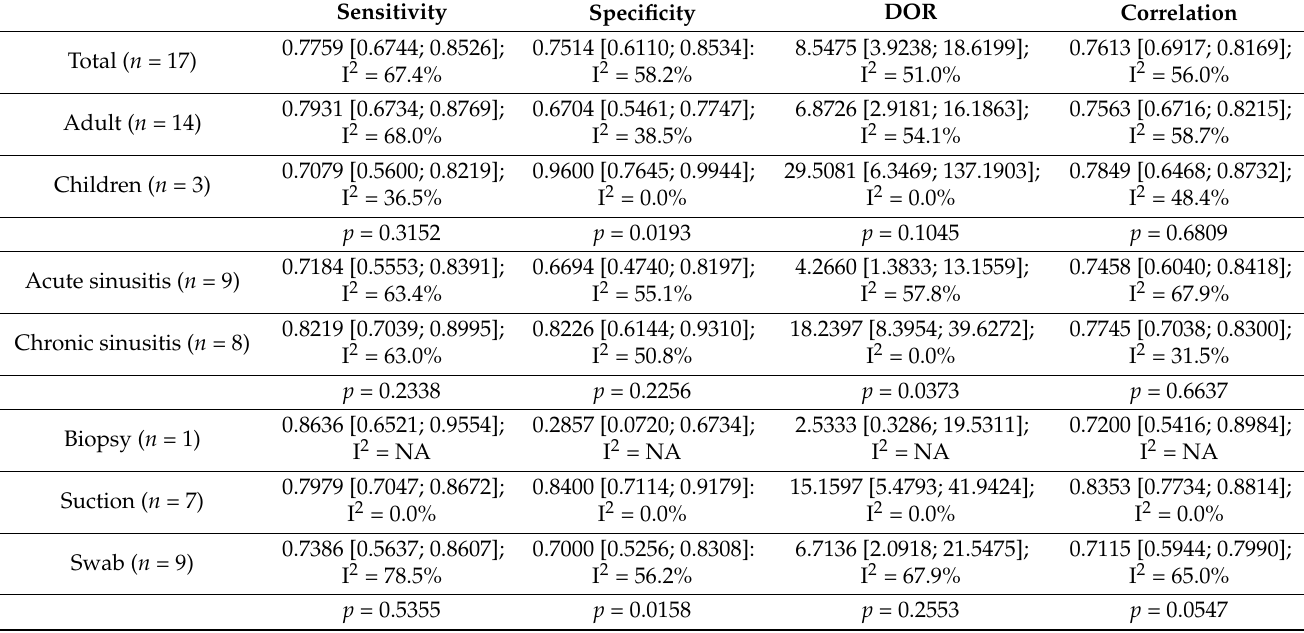
Figure 2. Correlation between the middle meatus and maxillary sinus culture results [1,3,4,6–13,17–20]. Table 1. Subgroup analysis by detection method.